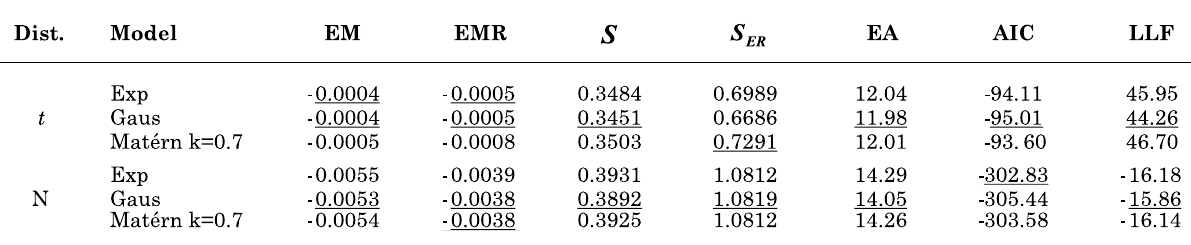
Table 3. Results of model validation for the soybean yield